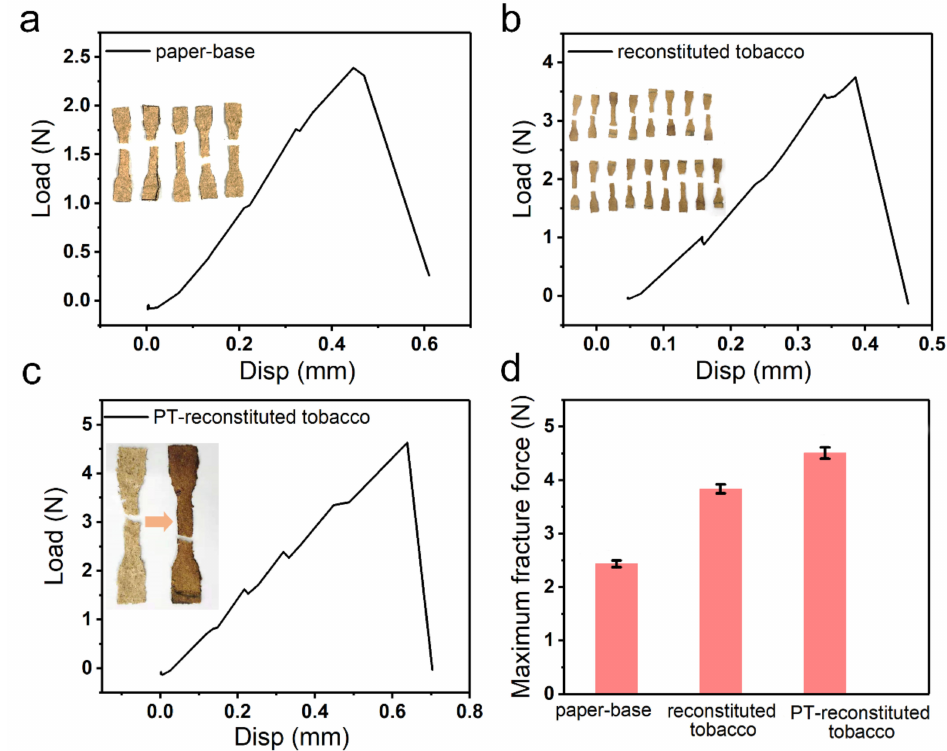
Figure 9. Tensile performance of different tobacco sheets. Tensile fracture behavior of ( a ) reconstituted tobacco paper-base, ( b ) reconstituted tobacco, and ( c ) PT-reconstituted tobacco. The maximum tensile fracture force of ( d ) reconstituted tobacco paper-base, reconstituted tobacco and PT-reconstituted tobacco. Inset images: parallel experiments of the tensile fracture in multiple